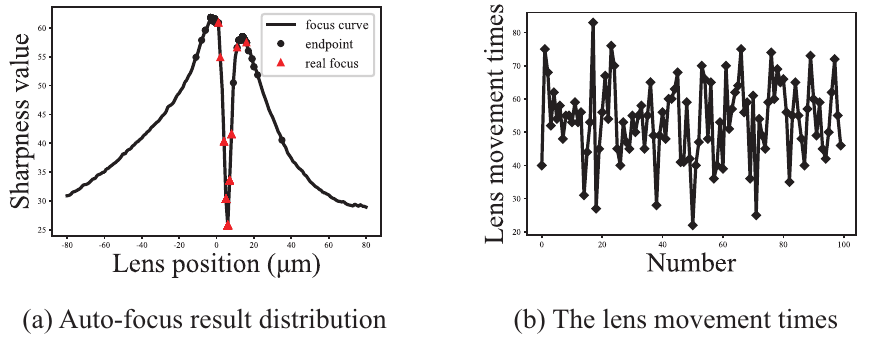
Figure 10. The actual number of move of microscope lens with different region search